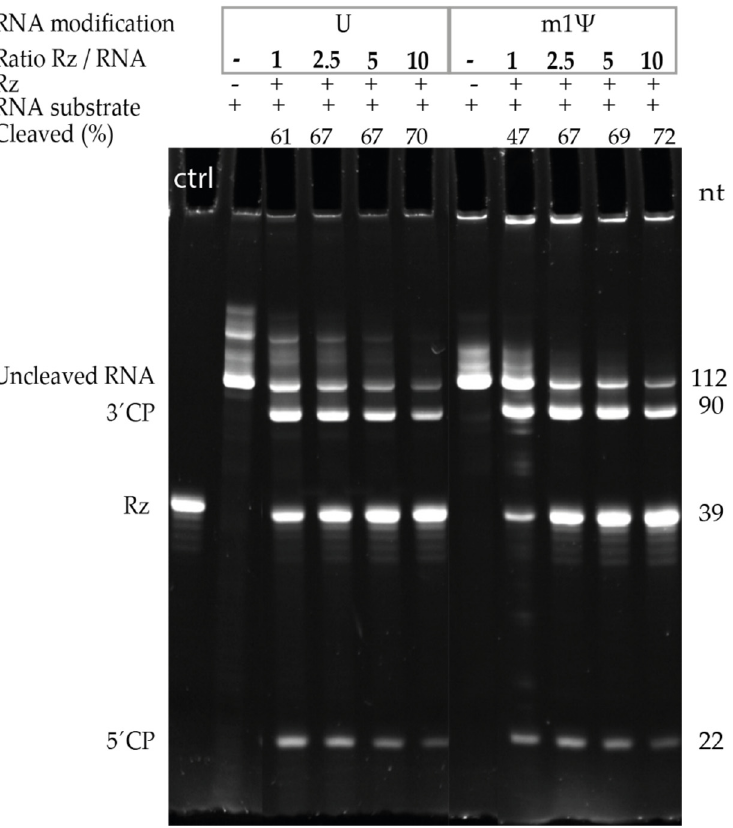
Figure 2. Optimization of molar ratio of ribozyme to the IVT mRNA substrate. A fixed amount of U-containing or m1 Ψ -containing uncapped mRNA was cleaved using increasing amounts of Rz1, and the resulting mixture was visualized using 21% PAGE, 8 M urea. The cleavage efficiency of Rz1 was assessed for increasing Rz to IVT mRNA substrate molar ratios, based on ratios between uncleaved RNA (112 nt long) and 3 ′ cleavage products (3 ′ CP = 90 nt long). Molar ratios of Rz to RNA substrate from 1 to 10 were tested, resulting in approximately 50 to 70% cleavage. Rz was used as a control (ctrl). 5 ′ CP: 5 ′ cleavage products; nt: Nucleotides.